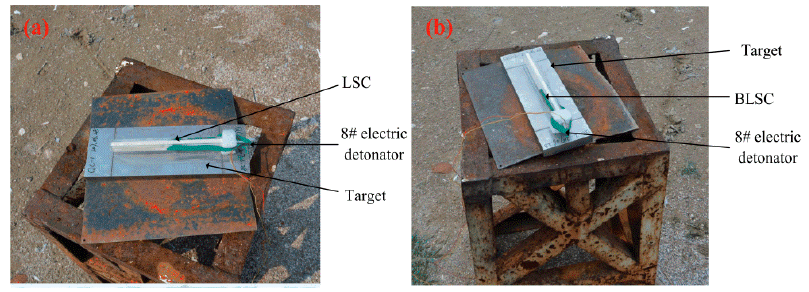
Figure 5. ( a ) Main charge; ( b ) BLSC and target.